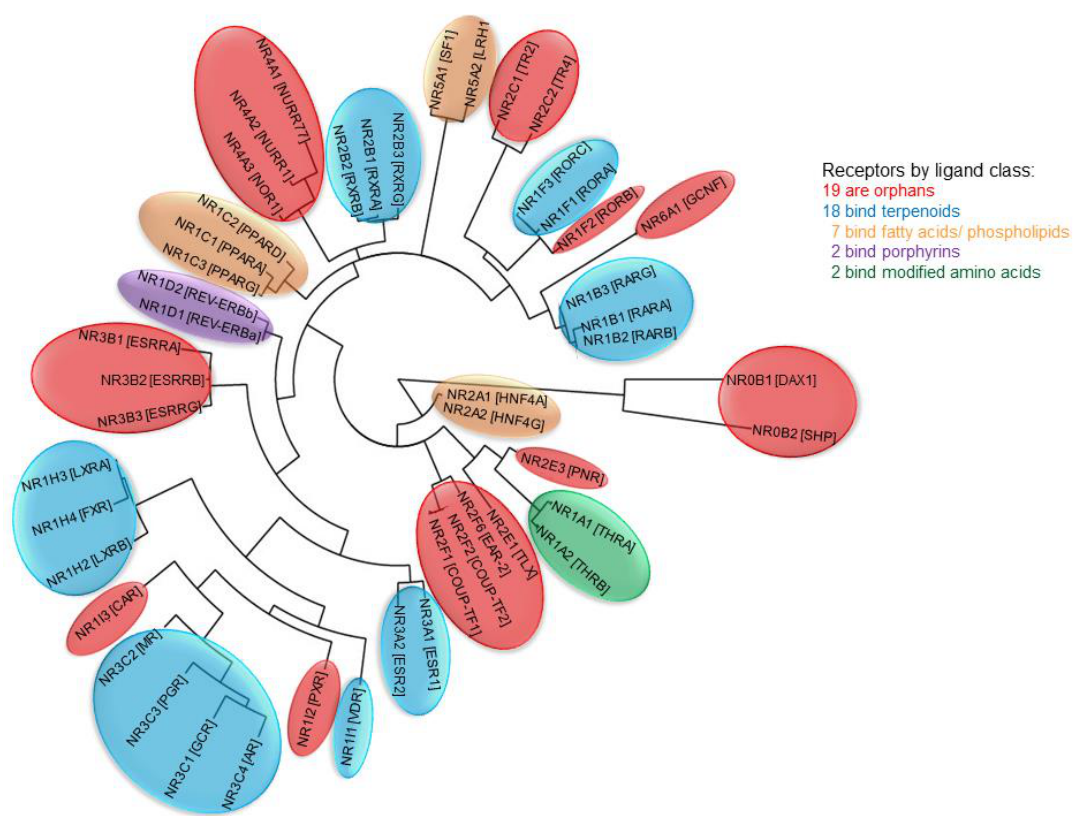
Figure 2. The 48 human NHRs and their ligands. Nuclear hormone receptors are defined by their homology to the steroid receptors [38]. This feature distinguishes the NHRs from other nuclear receptors regulated by small molecules such as the Per-Arnt-Sim (PAS) superfamily of transcription factors [39]. A dendrogram of the human nuclear hormone receptor family was generated using phylogeny.fr [40]. Color-coded balloons are used to label the ligand class for each individual NHR.